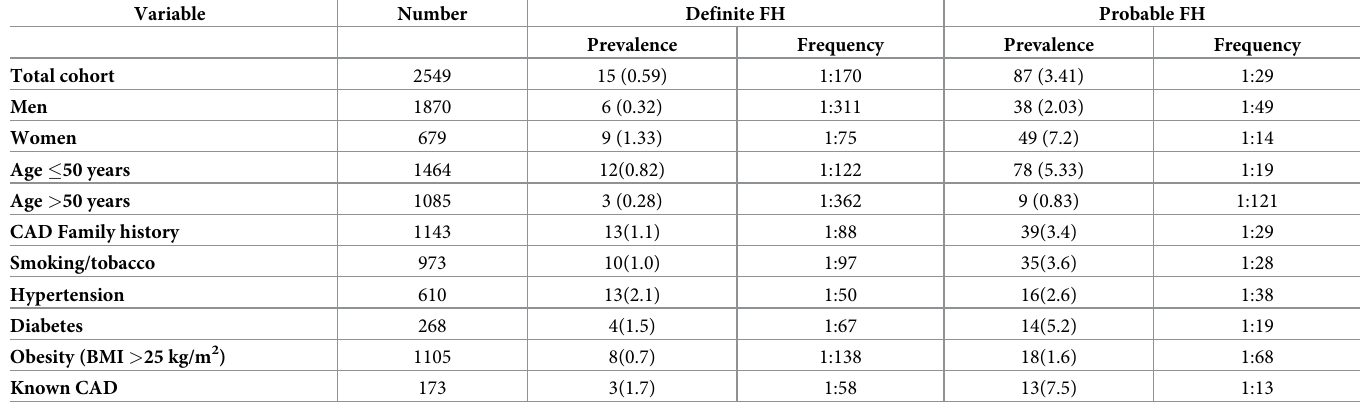
Table 2. Prevalence of definite and probable familial hypercholesterolemia in